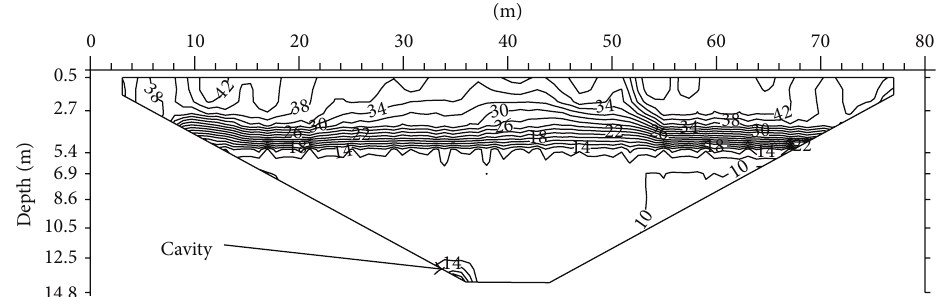
Figure 7: A 2D porosity image of the first profile line indicating cavity affected area.